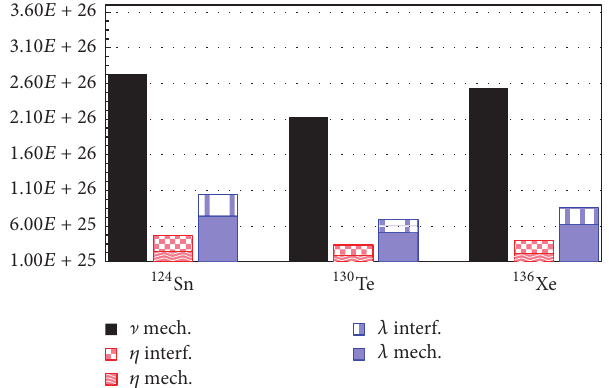
Figure 1: The calculated lifetimes and their uncertainties (the hatched bars) form the interference of the unknown CP phases. Fromlefttoright,thethreeverticalbarsforeachnucleuscorrespond to the mass mechanism, 𝜂 mechanism, and 𝜆 mechanism, respec- tively.